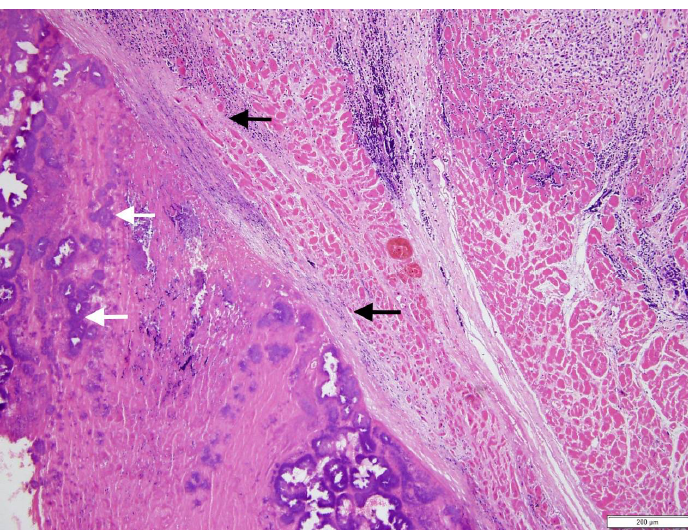
Figure 4. Effaced endocardium with attached fibrinonecrotic mass, containing bacterial colonies (white arrows), and separated from underlying myocardium by a zone of granulation tissue and fibrosis, which disrupts the cardiomyocytes (black arrows). H&E stain, magnification 10×.